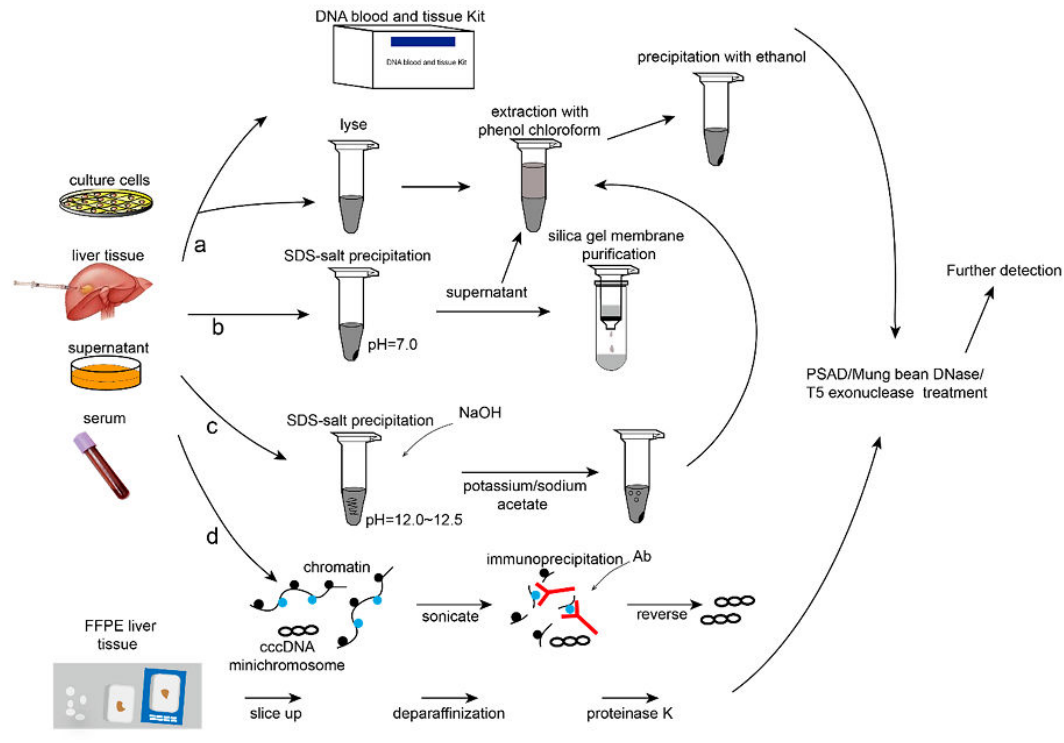
Figure 3. Various methods for cccDNA sample preparation. Methods ( a – d ) are used for cccDNA extraction and purification: Chromosomal DNA and viral DNA (protein-free DNA including cccDNA and protein-bound DNA such as intracellular HBV DNA encapsulated by HBcAg) can be purified using method ( a ), which extracts total DNA; only protein-free DNA can be isolated with methods ( b ) and ( c ). Method ( b ) is also known as the Hirt or modified Hirt procedure for rapid extraction of extrachromosomal protein-free DNA, including protein-free dslDNA, rcDNA and cccDNA; Method ( c ) is a modification of the alkaline lysis procedure for isolation of plasmid DNA. Specific protein-bound cccDNA is selectively precipitated by corresponding antibodies (Ab) in method ( d ). For in situ hybridization of cccDNA, formalin-fixed paraffin-embedded (FFPE) liver biopsy tissues are prepared differently. Nucleases [plasmid-safe adenosine triphosphate-dependent deoxyribonuclease (PSAD), mung bean DNase or T5 exonuclease] are used to degrade contaminating non-cccDNA, after which the sample is subjected to further detection procedures. SDS: sodium dodecyl